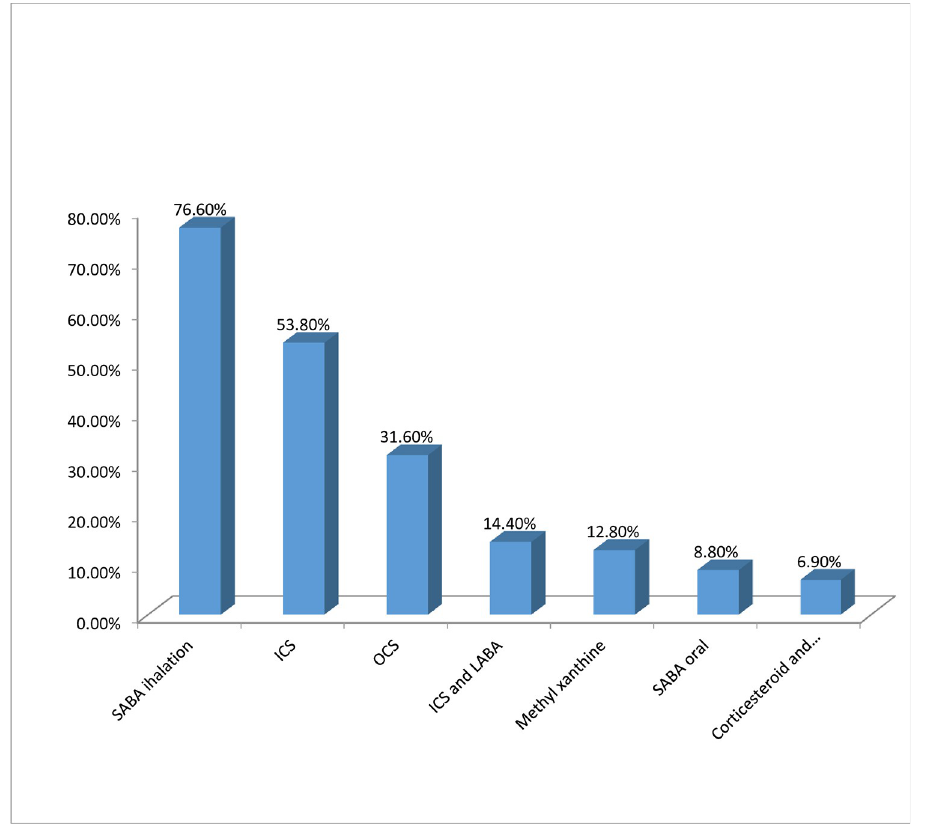
Fig 1. Type of medications used by study participants. Note; SABA: Short Acting Beta2 Agonist, ICS; Inhaled Corticosteroid, OCS; Oral Corticosteroid, LABA; long acting Beta2 Agonist.